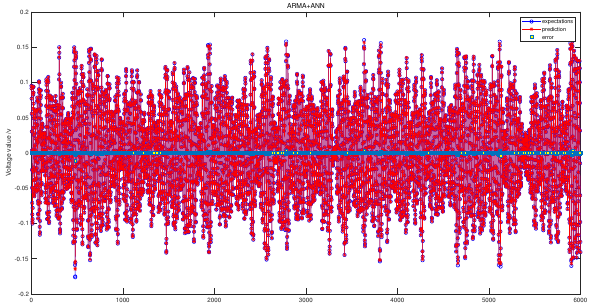
Figure 6. Prediction result of ARMA-ANN model for IF IMF1 time series.